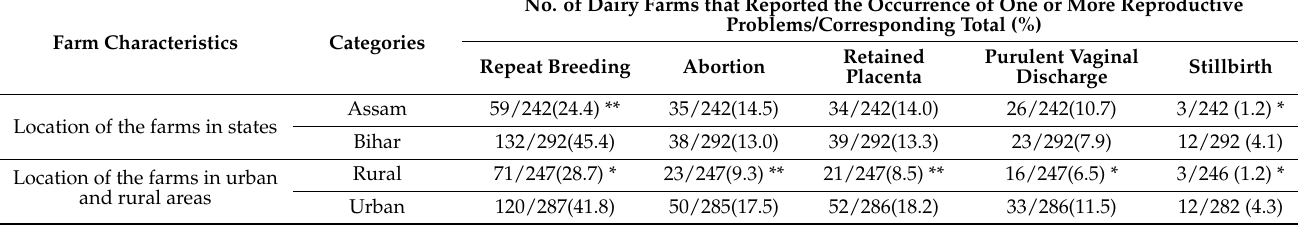
Table 1. Dairy farms with reproductive problems under different farm characteristics with level of significance between categories.